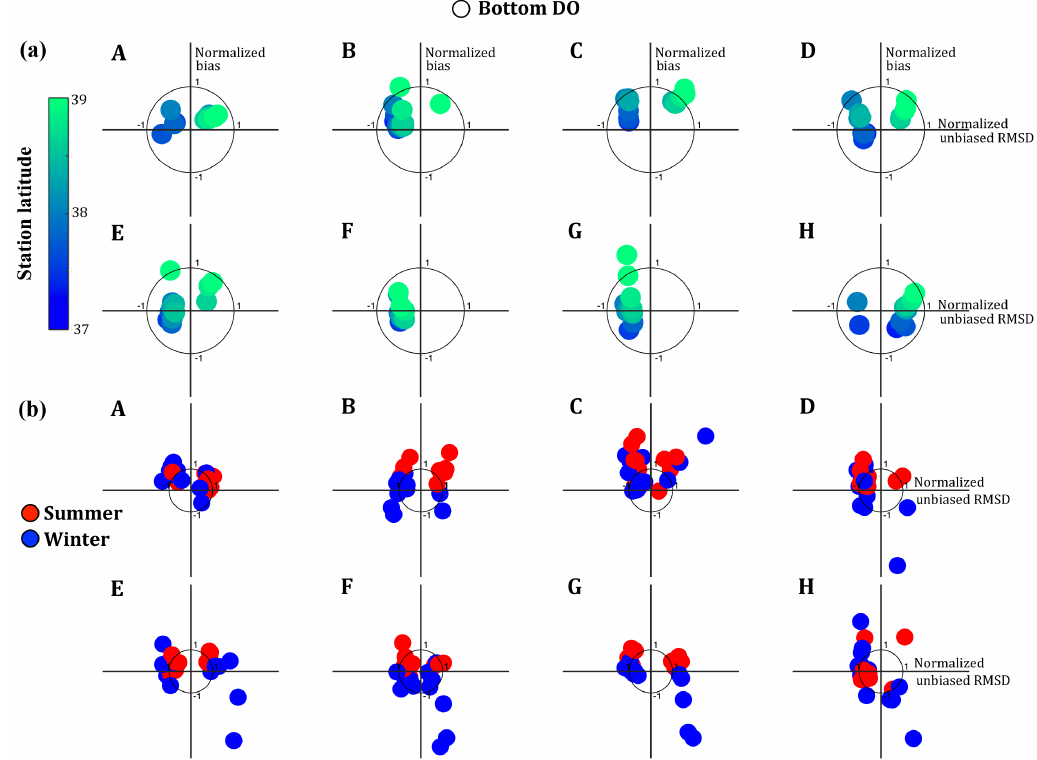
Figure 5. Normalized target diagrams for Models A–H demonstrating the (a) temporal and (b) spatial skill in resolving the variability of bottom dissolved oxygen concentrations. In (a) the individual dots represent the 13 stations along the main stem of the Chesapeake Bay. In (b) the dots represent the 24 months of 2004–2005 and are delineated by color: red is summer (May–September) and blue is winter